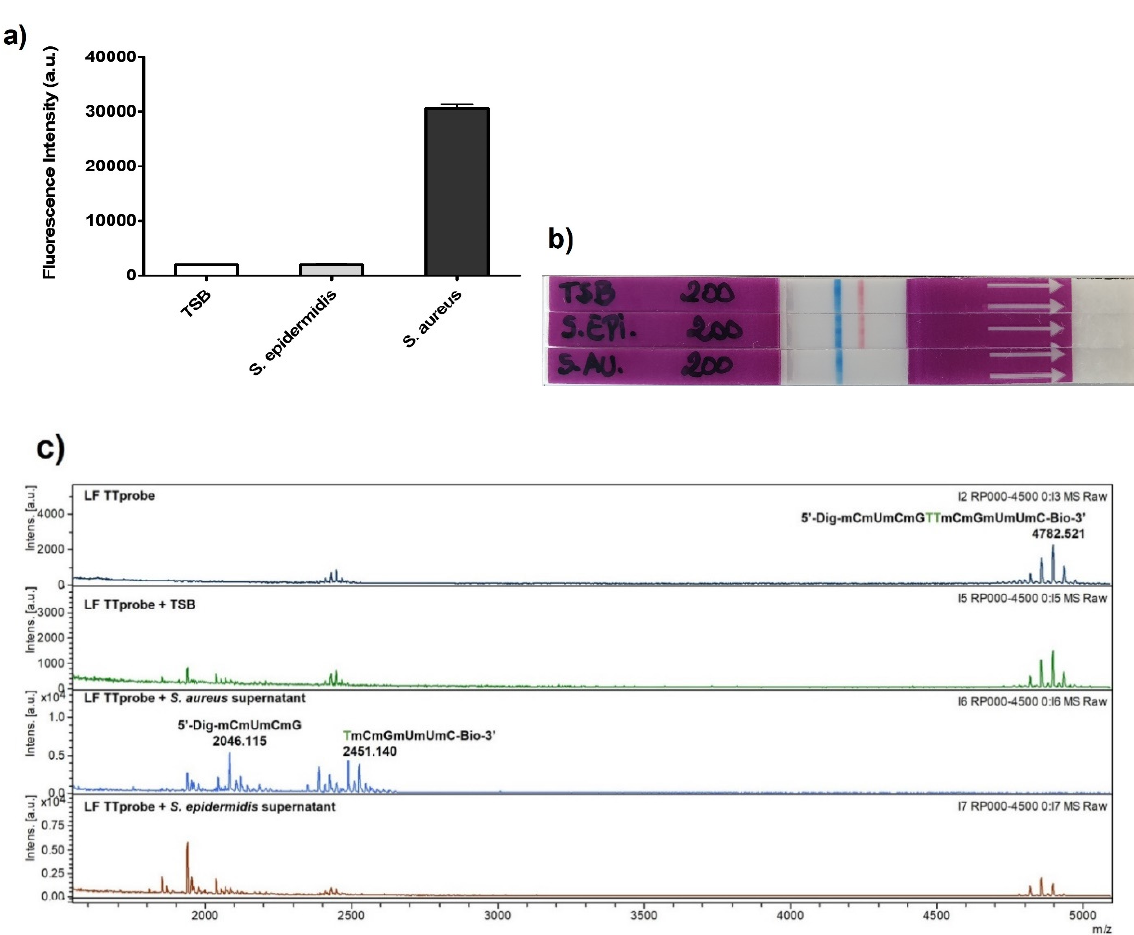
Figure 5. Comparison of three different techniques that prove the versatility of the TTprobe and its specificity for S. aureus . The cleavage of the TT probe by S. aureus was characterized by ( a ) fluorescence, where a significant increase in fluorescence intensity was detected, ( b ) lateral flow, proven by the absence of line at the test band, and ( c ) the MALDI-TOF MS spectrum of the digested and non-digested LF-TT probe.